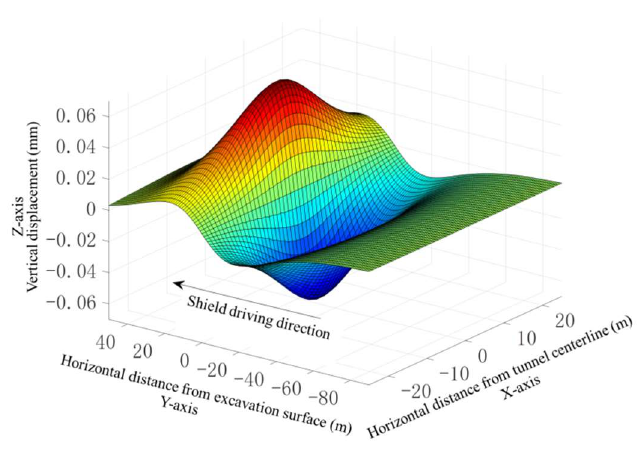
Figure 10. Ground movements induced by support pressure.